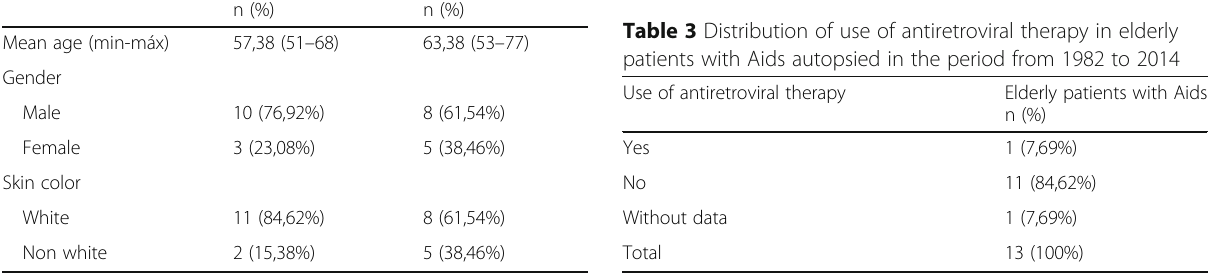
Table 1 General characteristics of the sample of 26 elderly people, with and without Aids, autopsied in the period from 1982 to 2014 General characteristics